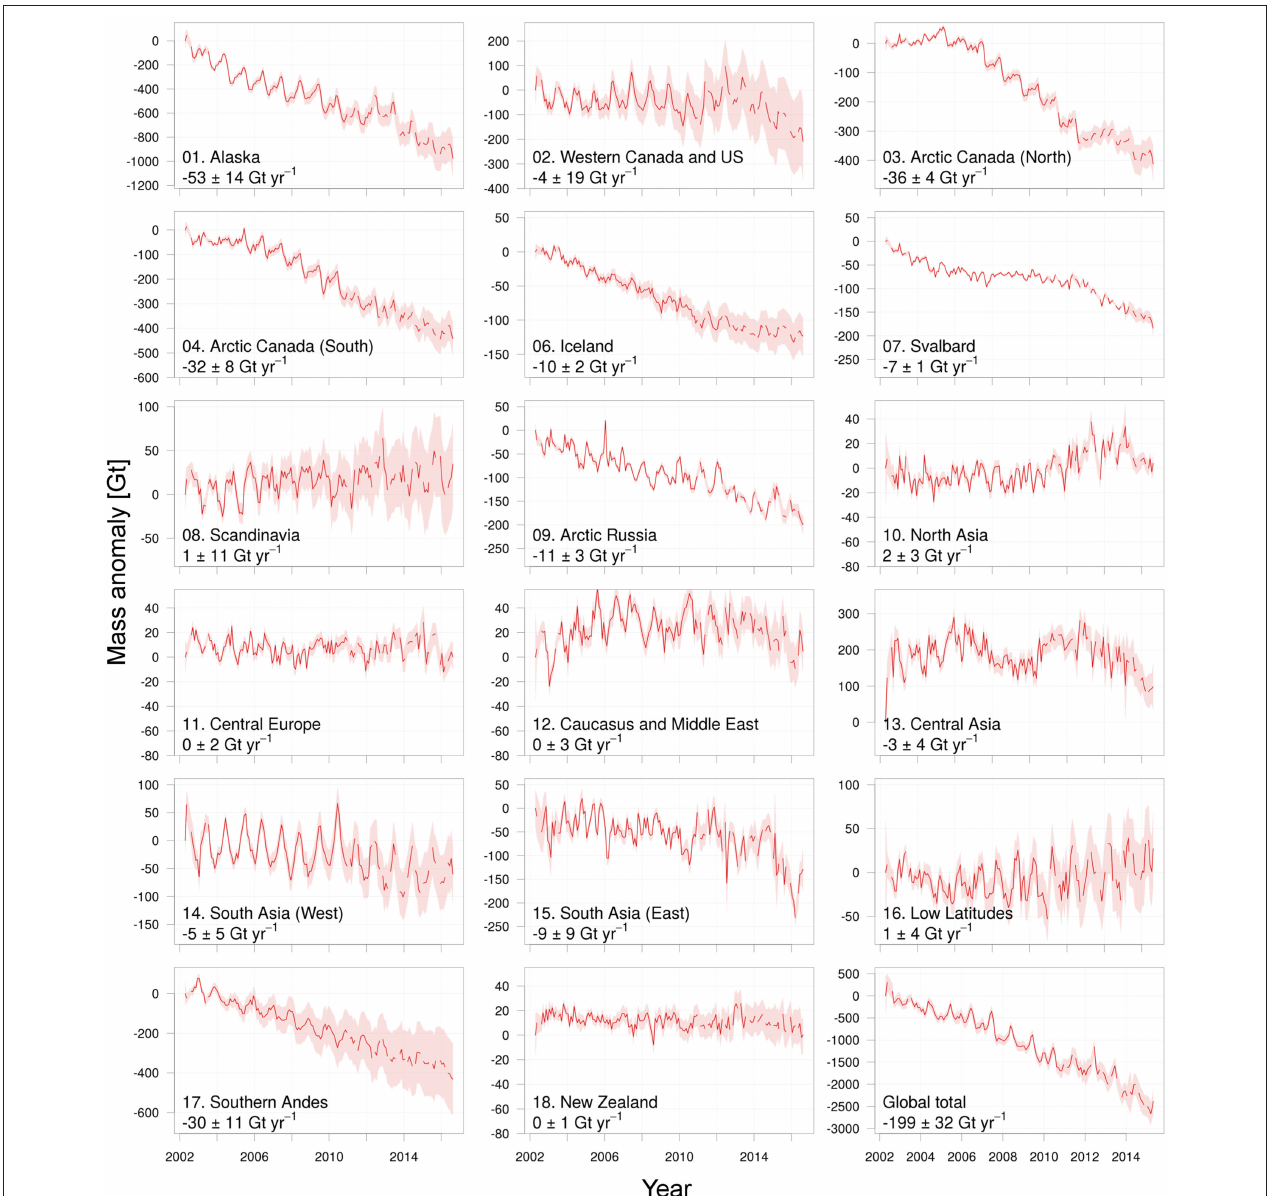
FIGURE 2 | Time series of cumulative mass anomalies for all RGI regions, except for the peripherial glaciers of Greenland and Antarctica, which cannot be resolved by GRACE. Note the difference in range on the y-axis between the different subfigures. Uncertainties grow in time due to the cumulative effect of uncertainties in the GIA